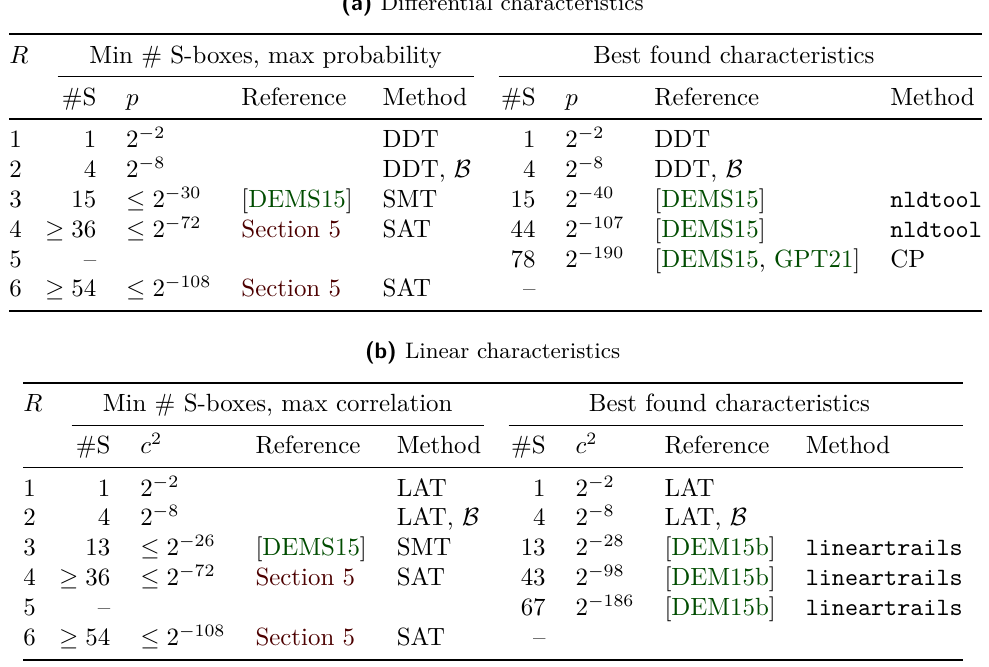
Table 1: Bounds for differential cryptanalysis of the reduced R -round Ascon permutation. “Min/Max” refers to provable bounds on the minimum number of active S-boxes and maximum probability, where “ ≥ / ≤ ” indicates not necessarily tight bounds without a matching characteristic. “Best” (wrt. either the number of S-boxes #S, probability p , or squared correlation c 2 ) refers to best characteristics found using heuristic search tools. DDT = Differential distribution table of the S-box, LAT = Linear approximation table, B = Branch number of the linear layer, SAT = Satisfiability, SMT = Satisfiability modulo theories, CP = Constraint programming, MILP = Mixed-integer linear programming, nldtool is a dedicated guess-and-determine tool for differential cryptanalysis [MNS11].